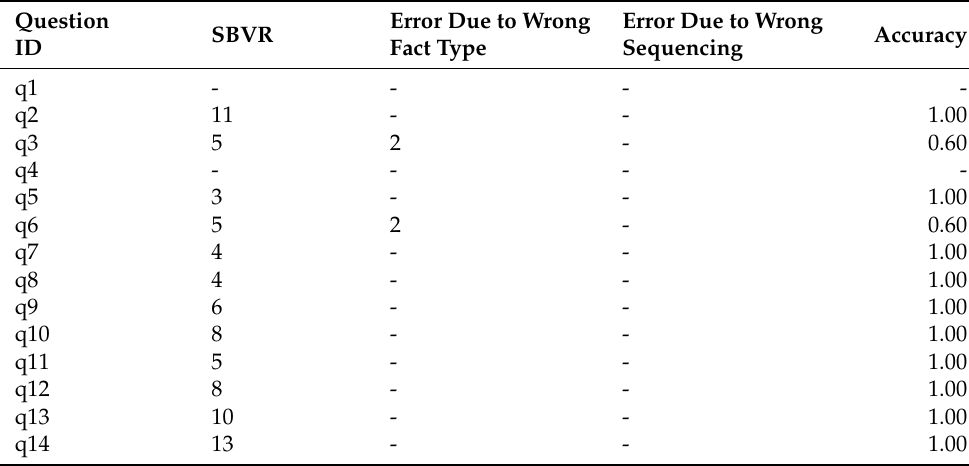
Table 5. Experimental results of generating SBVR in dataset_university1.